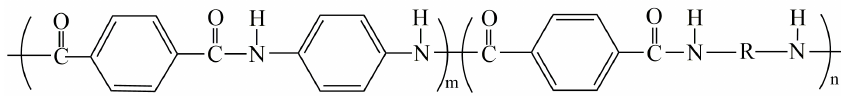
Figure 1. The molecular structure of F-III fiber.